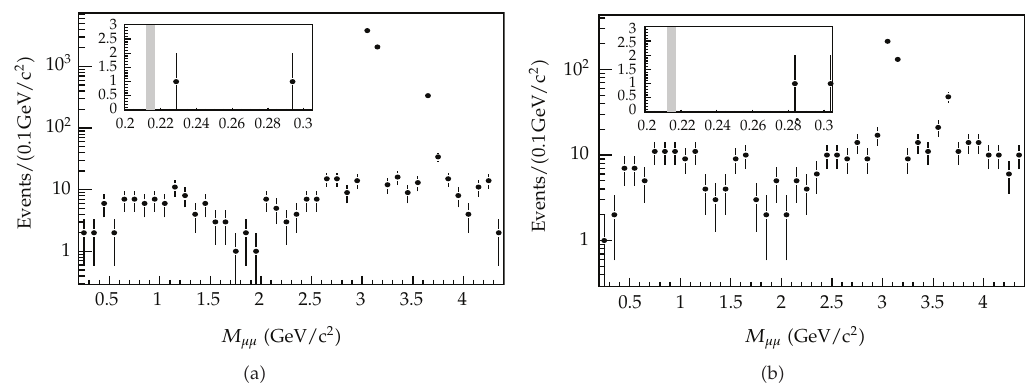
Figure 6: Distribution of the dimuon invariant mass for B → K ∗ 0 μ (cid:8) μ − (cid:2) a (cid:3) and B → ρ 0 μ (cid:8) μ − (cid:2) b (cid:3) signal events for Belle data. The signal regions are shown as dashed bands in the